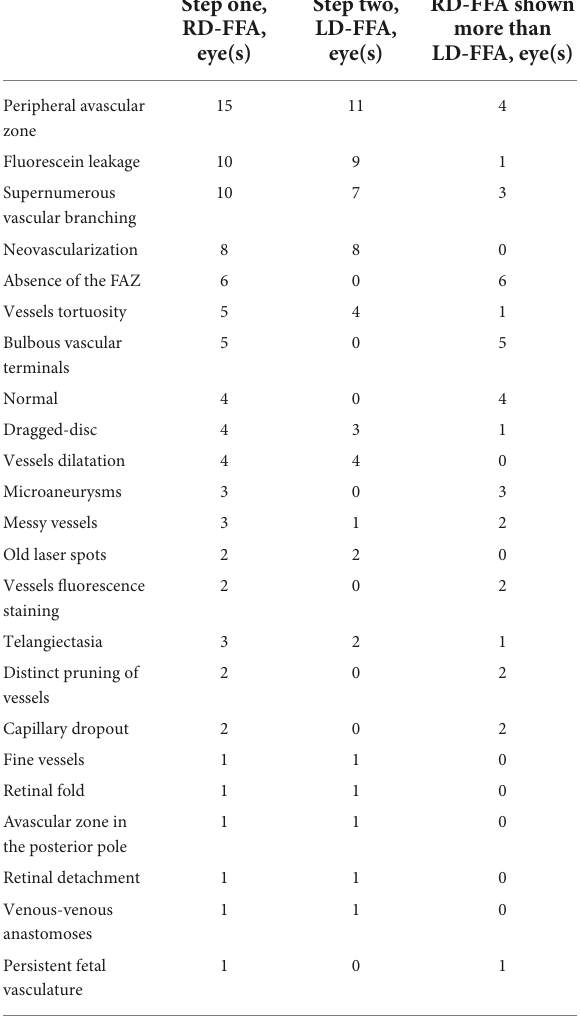
TABLE 1 Results of the two-step